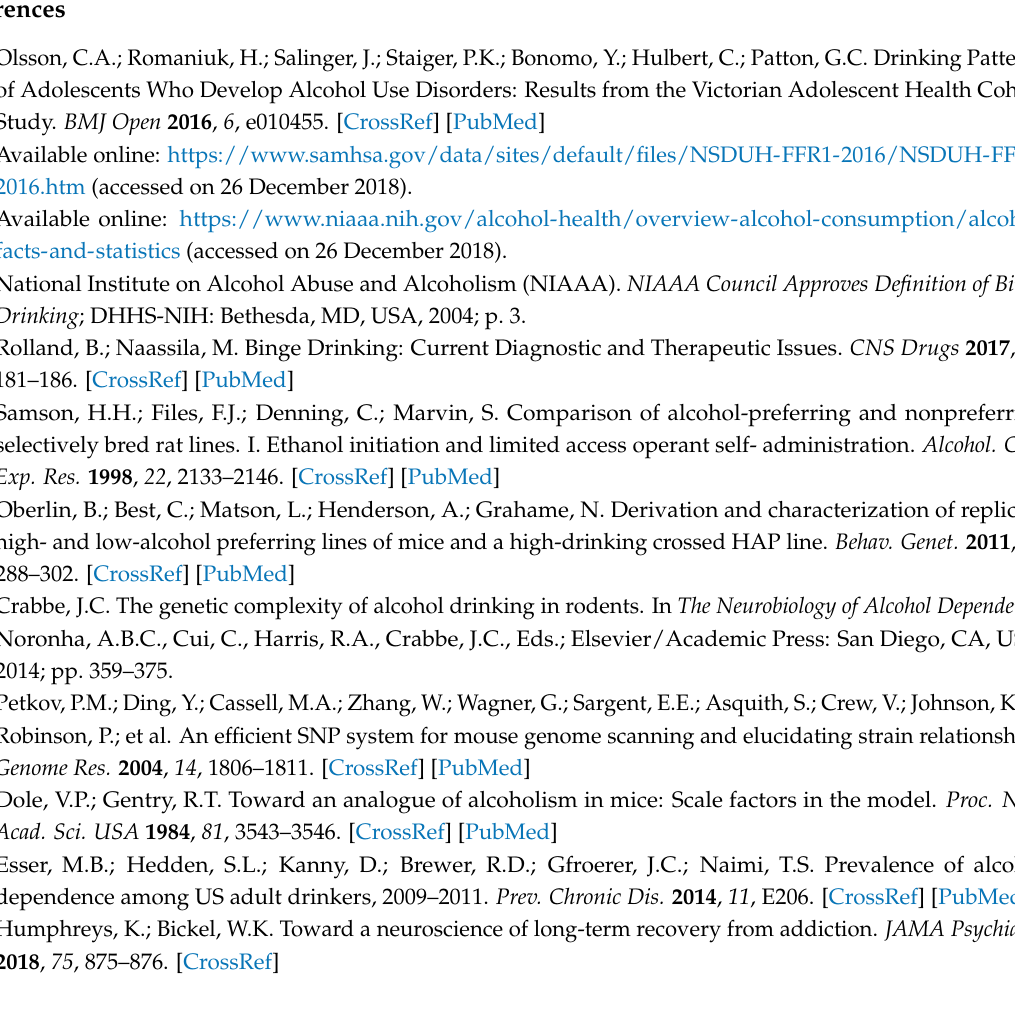
Figure S1: Intake across days of EtOH taste aversion conditioning in females and males, Figure S2: Day 2 intakes and blood alcohol levels after different EtOH